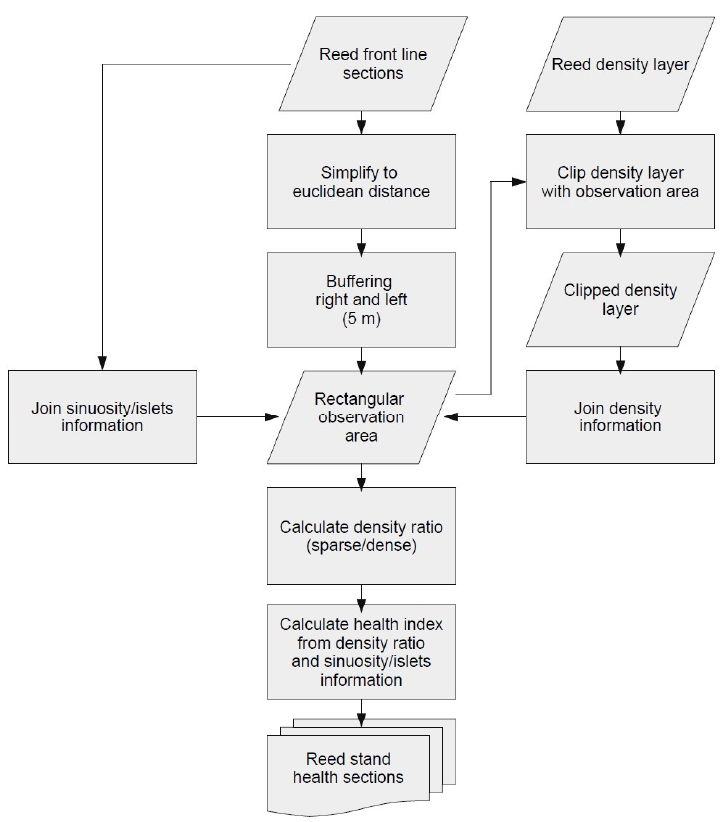
Figure 4. Reed stand health sections flowchart.